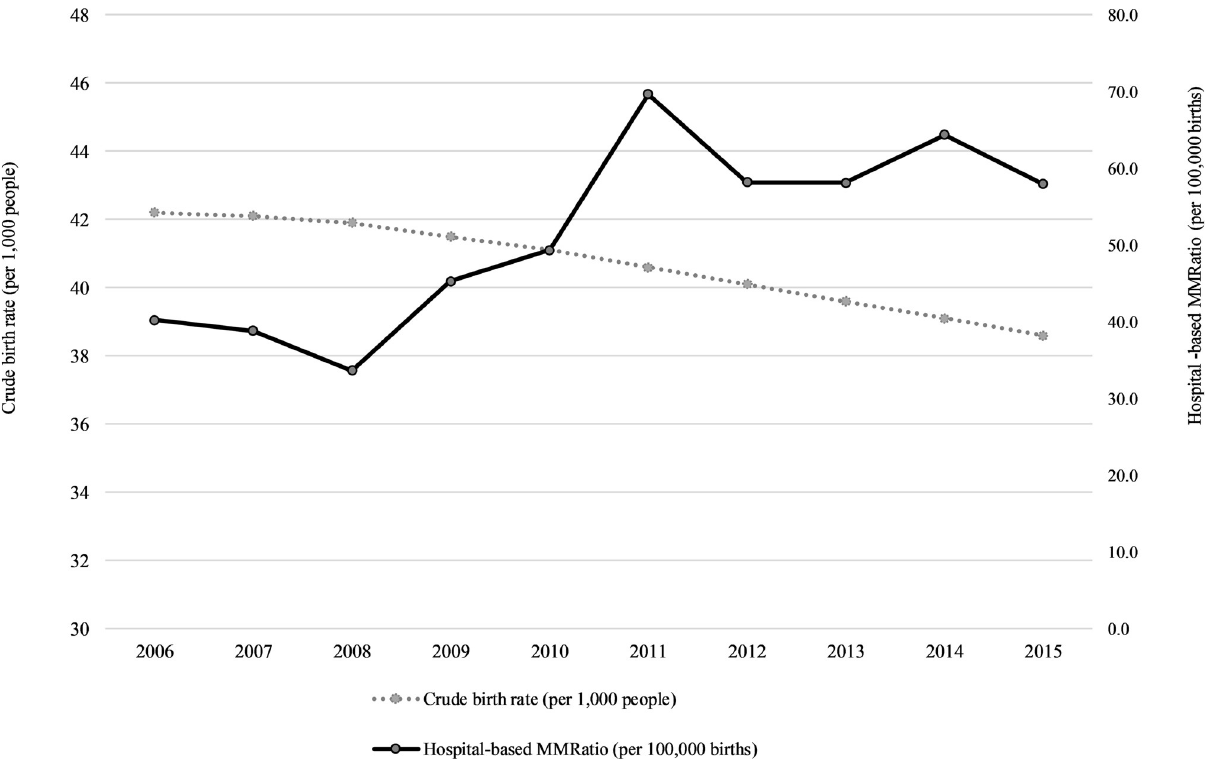
Fig 4. Annual crude birth rate per 1000 people and hospital-based MMR per